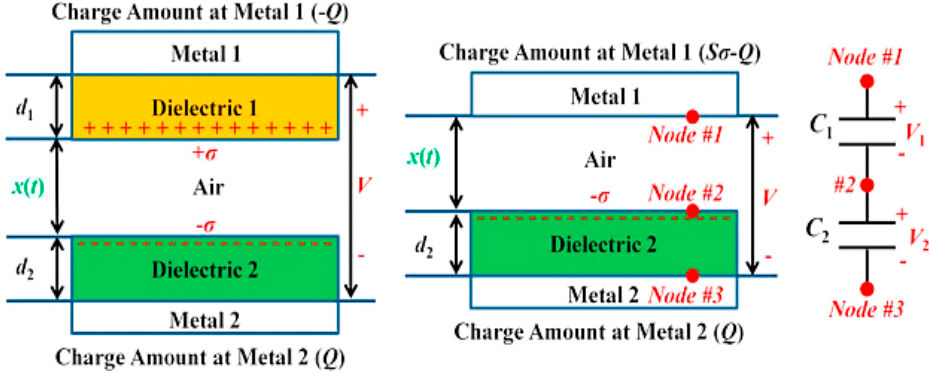
Figure 12. Triboelectric pairs: dielectric-to-dielectric and conductor-to-dielectric contact [51]. The following equation expresses the capacitance of the tribo-dielectric